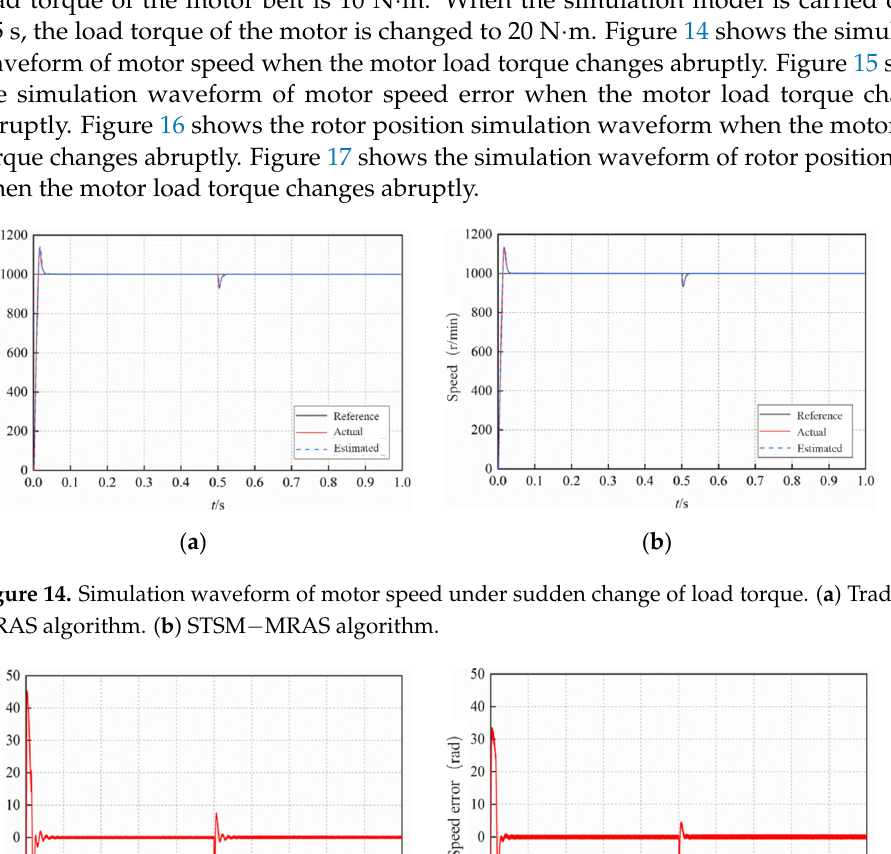
( b ) Figure 16. Simulation waveform of rotor position under sudden change of load torque. ( a ) Tradi ‐ tional MRAS algorithm. ( b ) STSM − MRAS algorithm. ( a ) ( b ) Figure 17. Simulation waveform of rotor position error under sudden change of load torque. ( a ) Traditional MRAS algorithm. ( b ) STSM − MRAS algorithm. As can be seen in Figure 14, in the case of torque mutation in constant torque area, the estimated speed of the motor by the two algorithms can always track the actual speed. When the load torque is suddenly changed at 0.5 s, the motor speed of the traditional MRAS algorithm has a drop of about 70 r/min. The motor speed of STSM − MRAS algo ‐ rithm drops at 65 r/min. As can be seen in Figure 15, in the process of motor startup, the error between the actual speed and the estimated speed of the traditional MRAS algorithm is 46 r/min. The maximum speed error of STSM − MRAS algorithm is 33 r/min. When the motor enters the